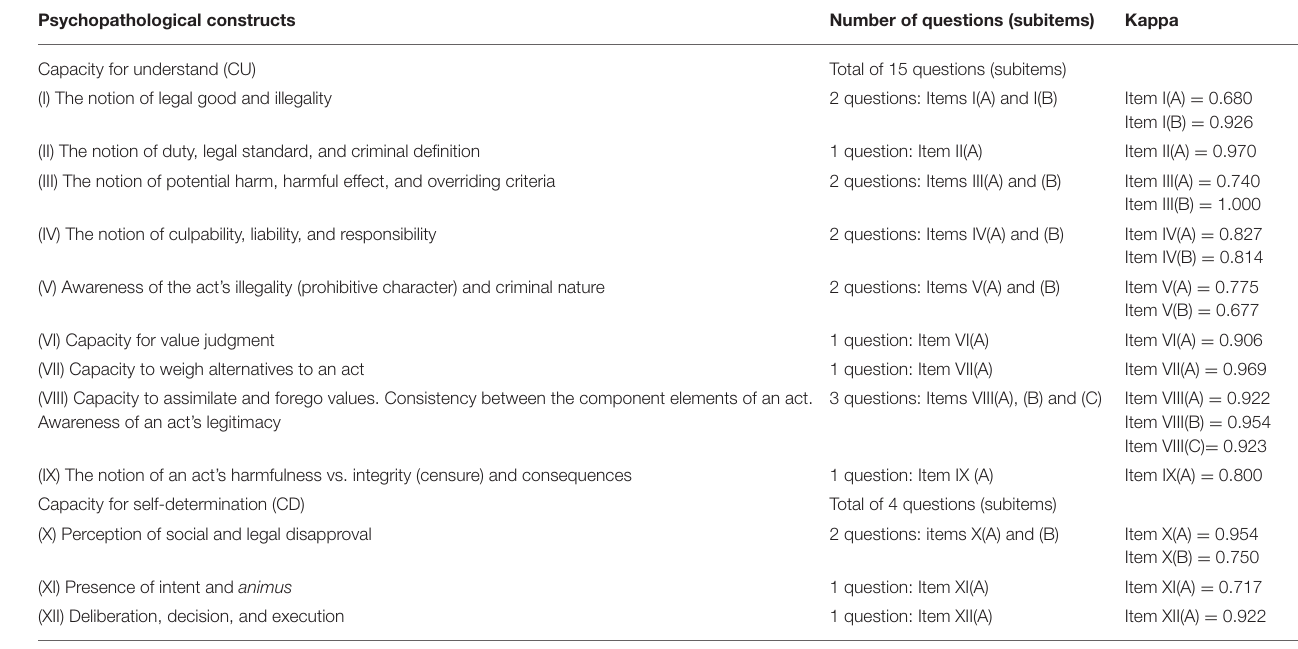
TABLE 1 | Psychopathological constructs of the CRS (items) and the respective number of questions, with division into subscales of understanding and self-determination and Kappa index. Psychopathological